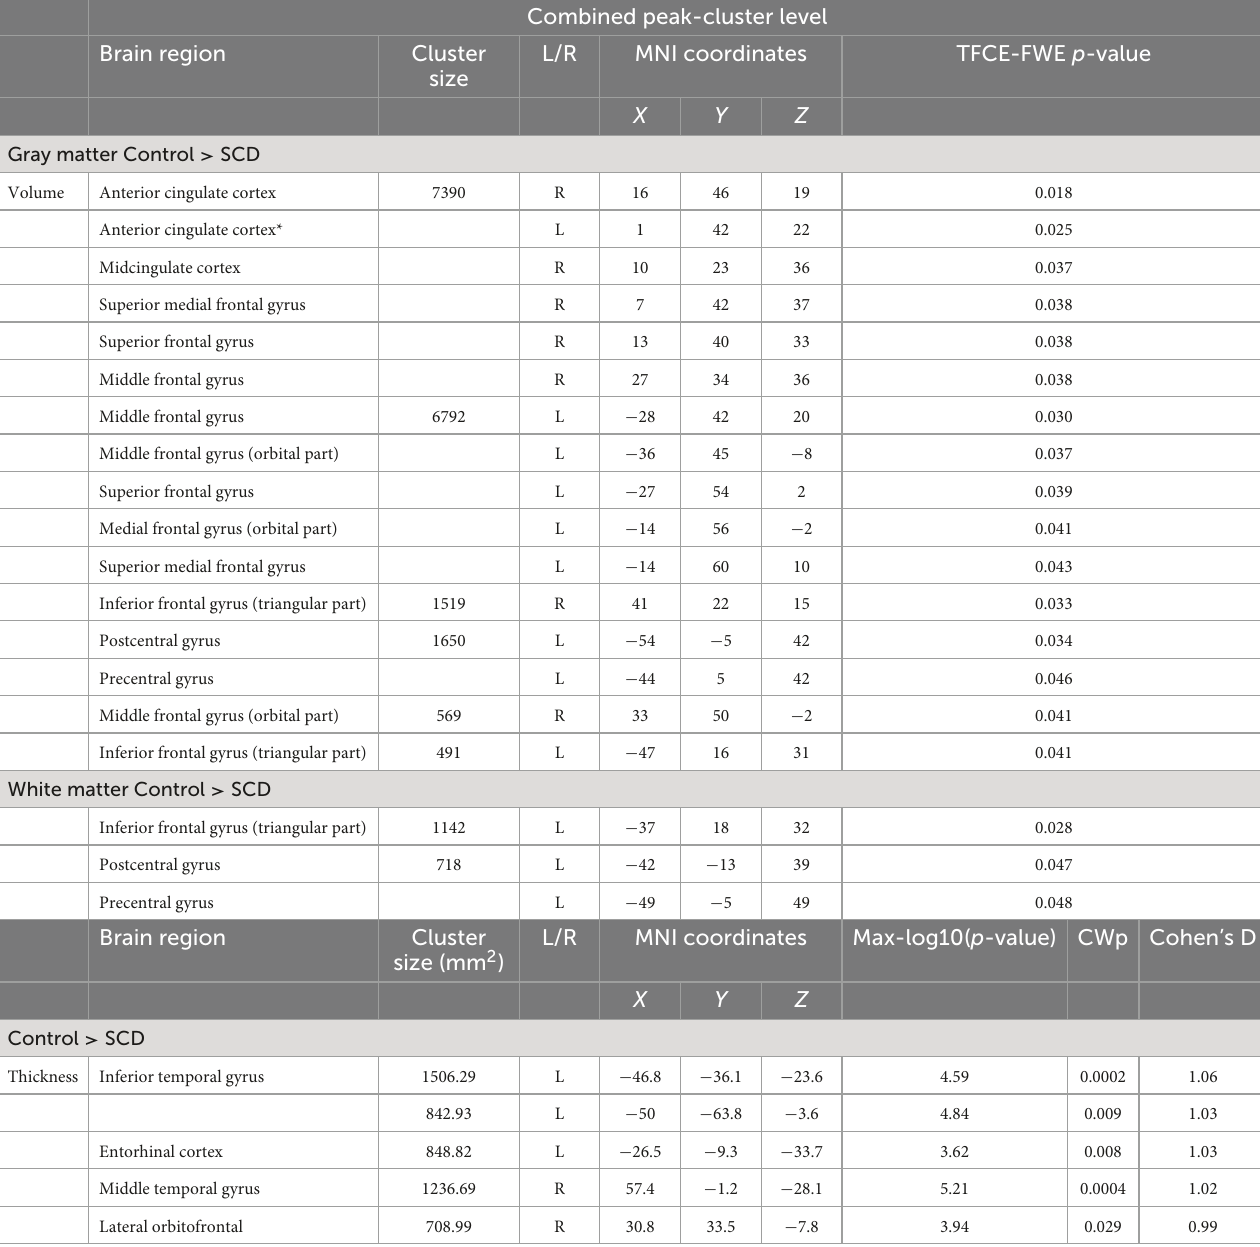
TABLE 2 Brain regions showing significant differences in gray matter (GM) and/or white matter (WM) volume and cortical thickness in the between-group